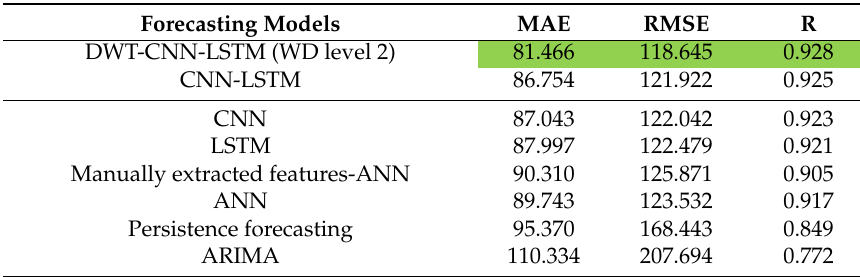
Table 10. The performance comparison of different cloudy days’ forecasting models using the dataset of Elizabeth City State